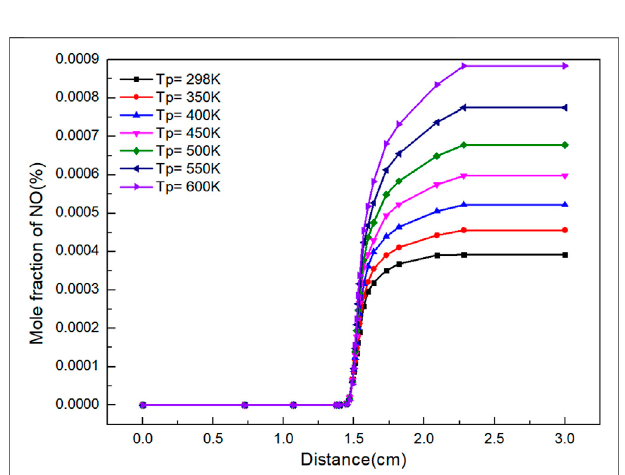
FIGURE 3 | Graph of NO mole fraction with distance under different preheating temperatures.